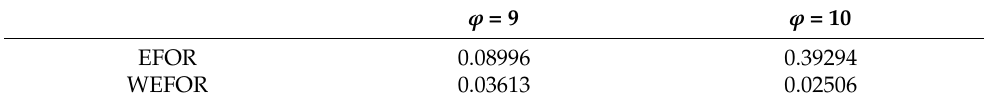
Table 2. Comparison of the NMSE values.